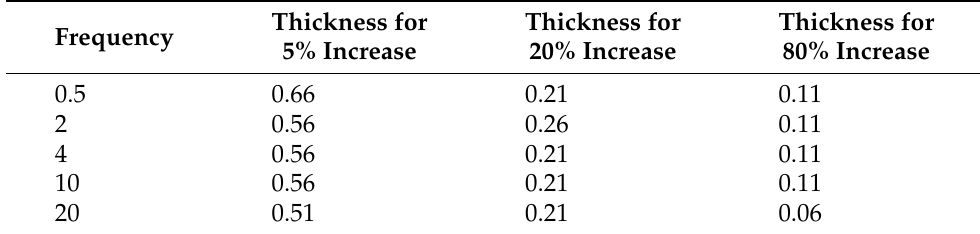
Table 6. Retrieved relative permittivity change of skin–olive oil double-layered configurations with